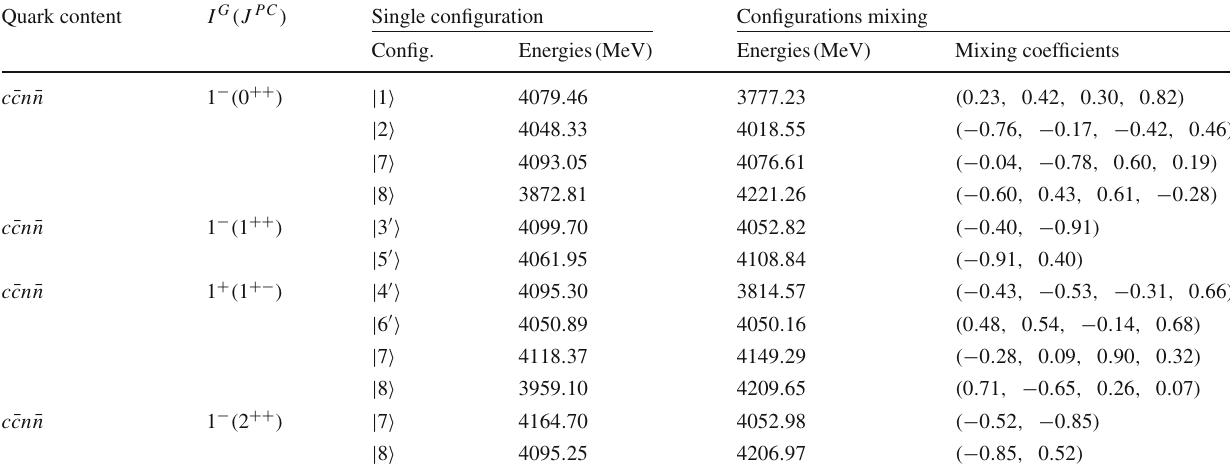
Table 9 As in Table 7 but for the case of Z c states Quark content Single configuration Configurations mixing Config. Energies(MeV) Energies(MeV) Mixing coefficients